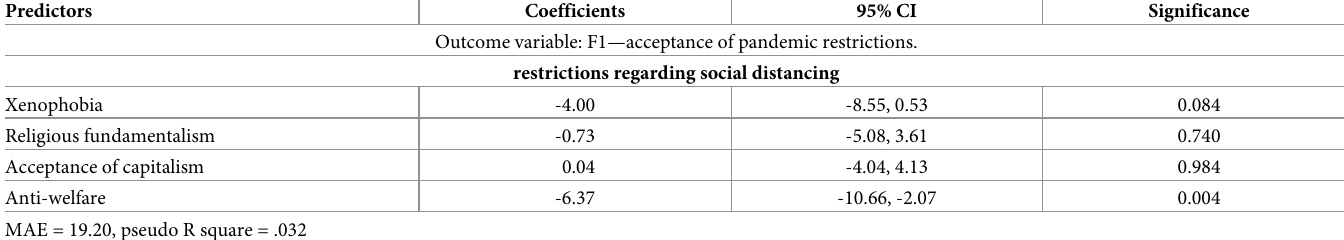
Table 4. Regression analysis predicting the acceptance of pandemic restrictions from political beliefs (N = 305).